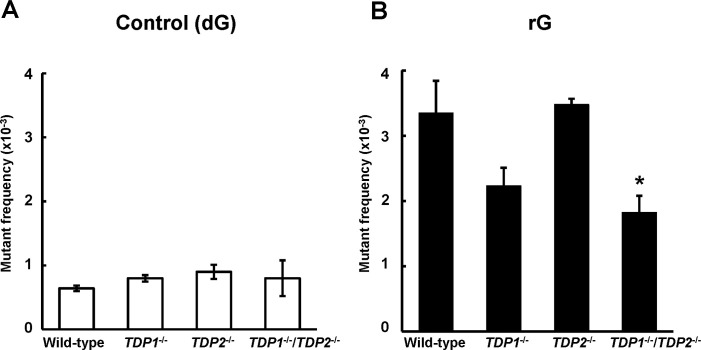
Frequency of supF mutants in a shuttle vector containing (A) dG or (B) rG replicated in wild-type (WT), TDP1-/-, TDP2-/-, and TDP1-/-/TDP2-/- cells. Mutant frequencies were calculated from the data of S1 Table. Data for control dG are expressed as the mean ± standard error (SE) of at least three independent experiments from two independent clones. Data for rG are expressed as the mean ± SE of three to six independent experiments from two independent clones. *Significant difference between the assessed and WT cells; P < 0.05.